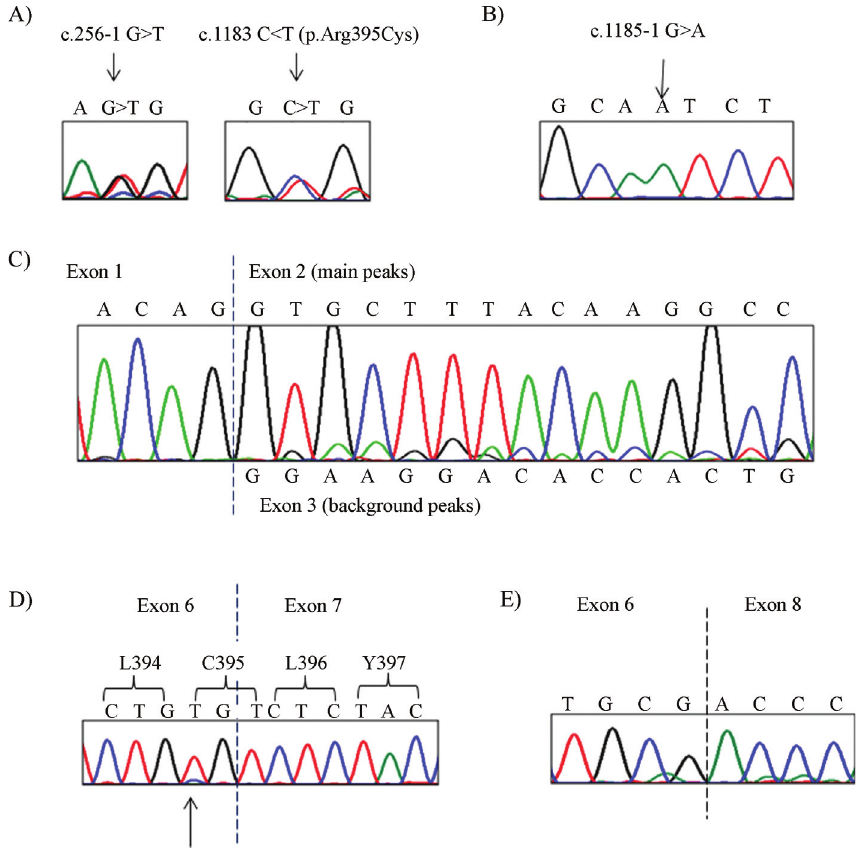
Figure 1 - Genomic and cDNA sequences showing case 1 and case 2 mutations . A) Case 1 genomic sequence showing heterozygote mutations. Black ar- rows point to mutated nucleotides. B) Case 2 genomic sequence. Homozygous mutation shown by arrow. C) cDNA sequence of case 1 (Exons 1-3). One haplotype has the normal sequence of exon 1 joined to exon 2, while the second haplotype shows exon 1 incorrectly joined to exon 3 (small peaks) (RefSeq NG_007959). D) cDNA sequence of case 1 showing exon 6 and 7 with the mutation at codon 395. E) cDNA sequence of case 2 showing the join of exon 6 to exon 8, skipping exon